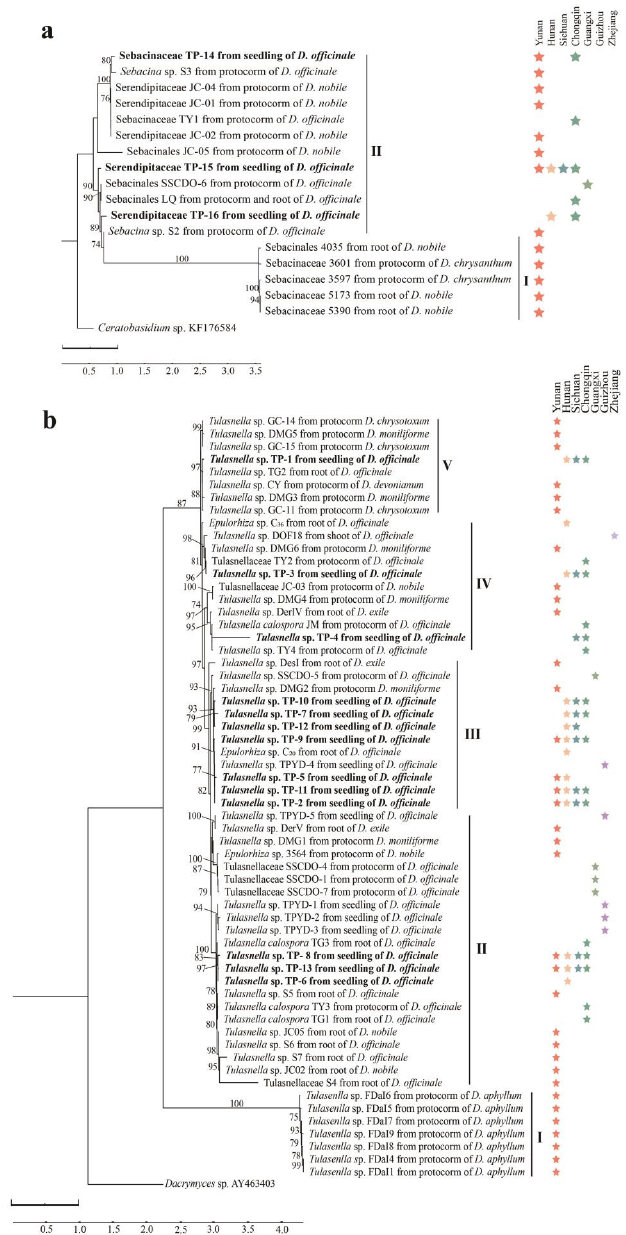
Figure 3. The two maximum-likelihood trees constructed using ITS sequences of 16 orchid myc- orrhizal fungi (in bold) obtained from seedling roots of Dendrobium officinale via ex situ seedling baiting in this study and of other mycorrhizal fungi reported to be associated with Dendrobium species. ( a ) Maximum-likelihood tree for Sebacinales; ( b ) maximum-likelihood tree for Tulasnellaceae. Numbers above branches are bootstrap probabilities (whenever ≥ 70%) based on 1000 replicates.